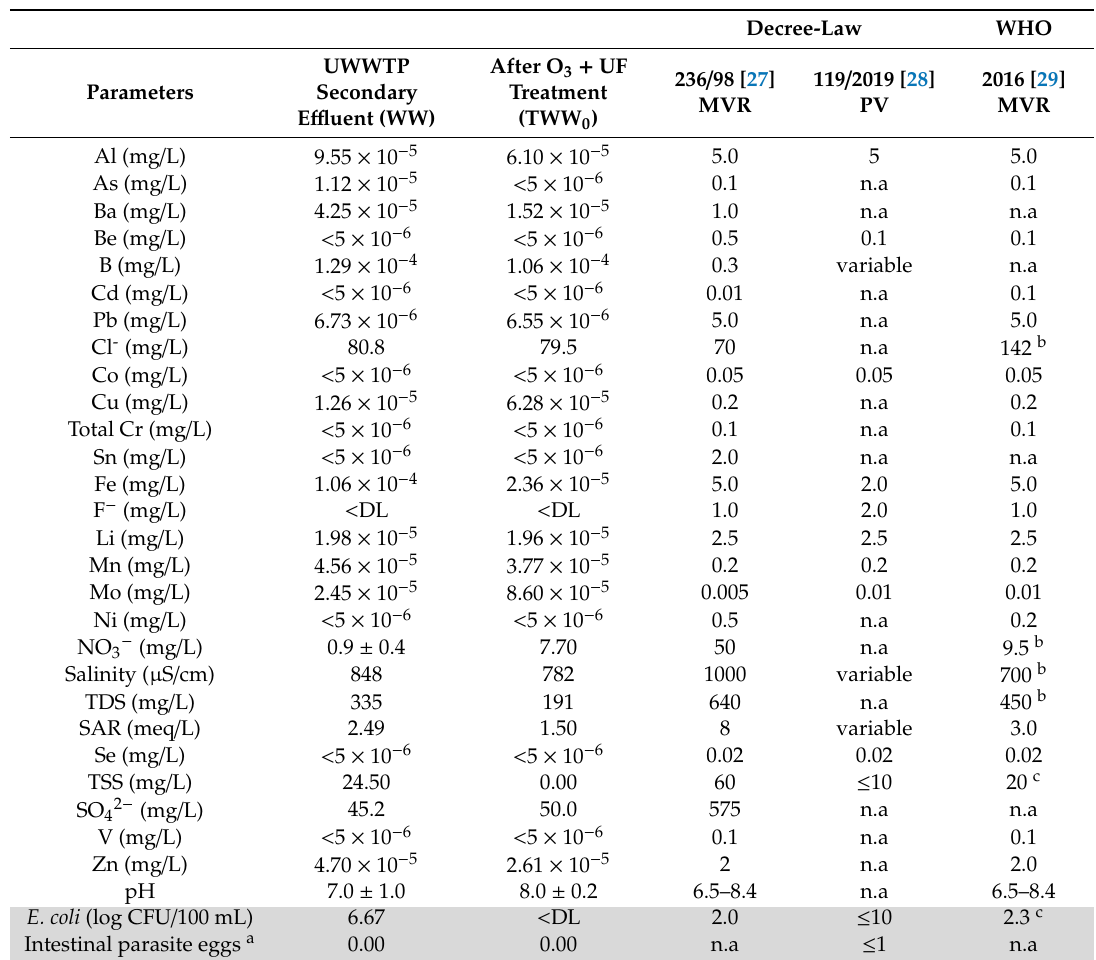
Table 1. Characterisation of the urban wastewater treatment plant (UWWTP) secondary e ffl uent, before (WW) and immediately after treatment (TWW 0 ), and standards of water for irrigation (Decree-Law 236 / 98) and wastewater reuse in irrigation without restriction, for urban wastewaters which treatment includes a disinfection step (Decree-Law 119 / 2019) and for wastewater reuse in the Eastern Mediterranean Region—WHO,